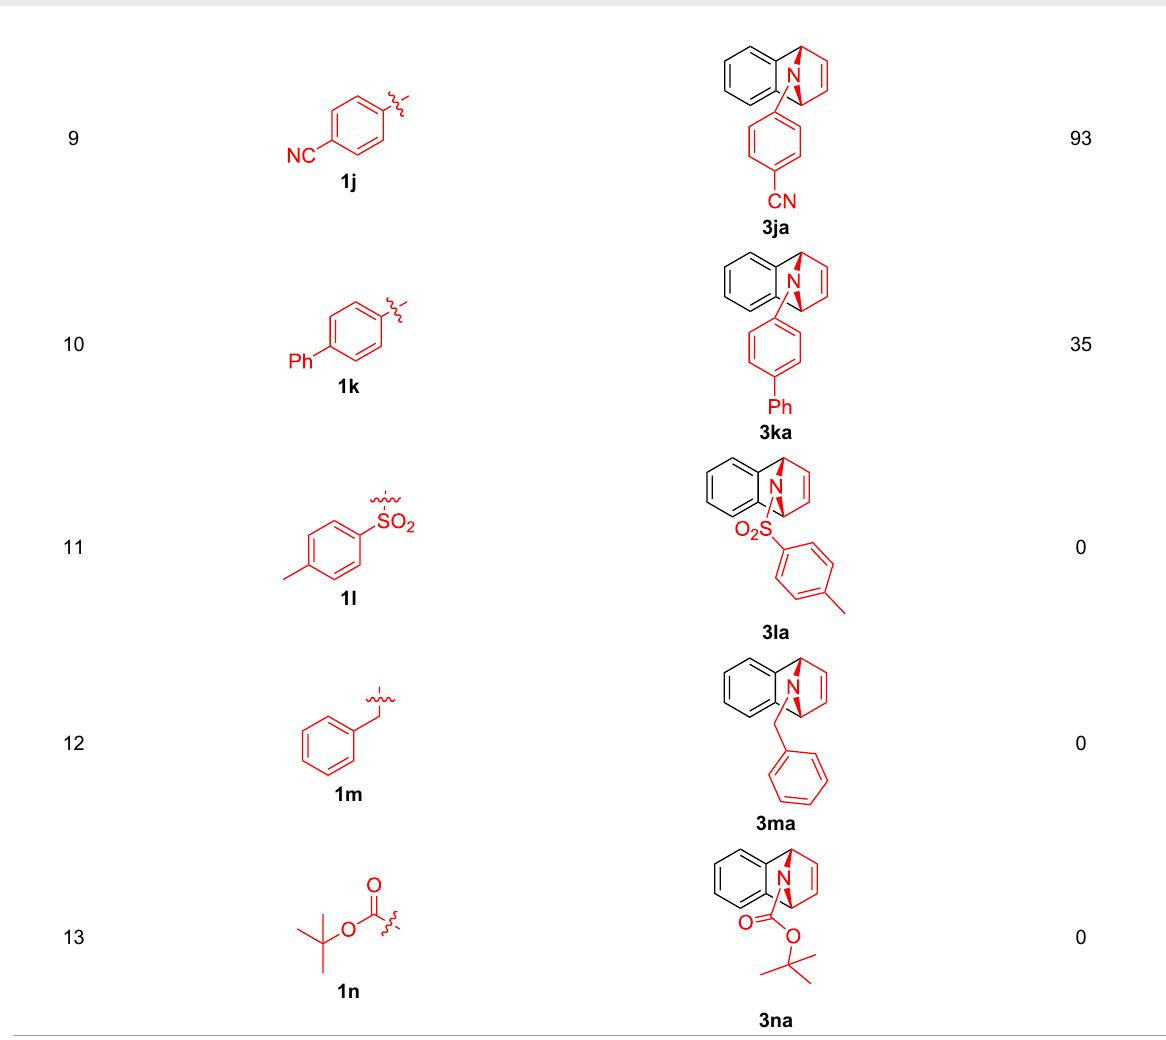
Table 3: Scope of N-substituted pyrroles 1 . a (continued)